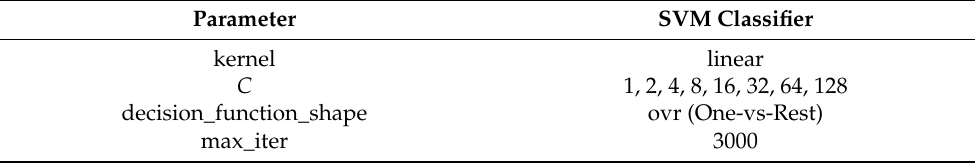
Table 4. Parameters of grid search for SVM